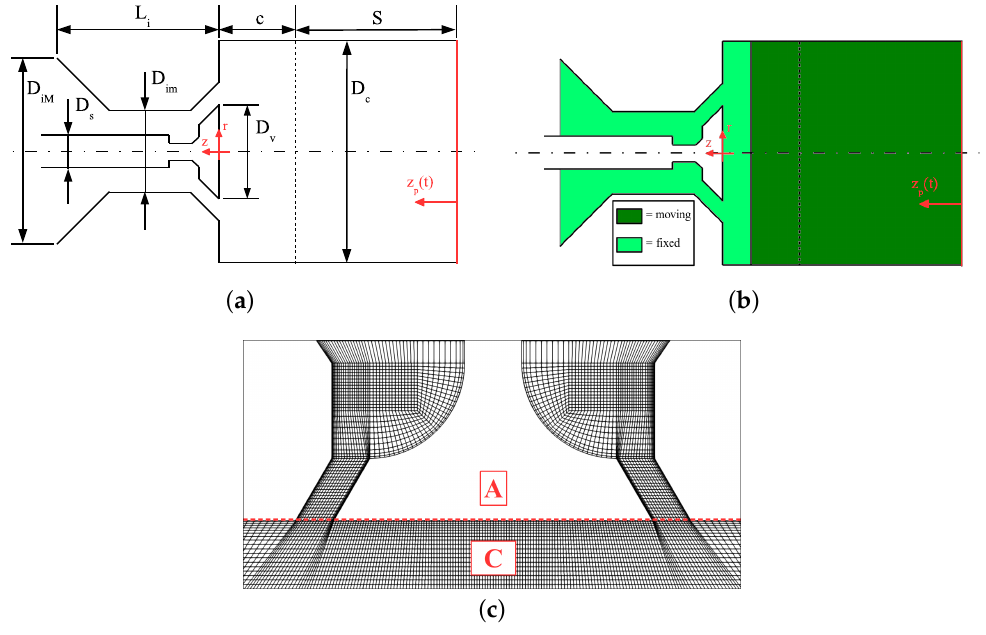
Figure 7. Details of the piston/cylinder assembly: ( a ) geometrical parameters; ( b ) moving mesh arrangement; ( c ) axial section of the mesh with the ZDES modes